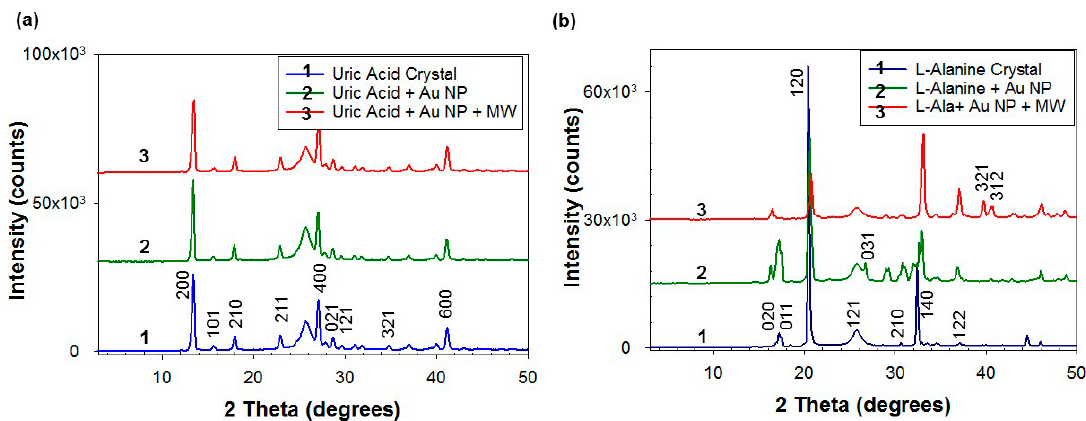
Figure 9. Powder X-ray diffraction (XRD) patterns of ( a ) uric acid before the MAMAD technique is applied (labeled as uric acid crystal), after incubation with gold nanoparticles (uric acid + Au NP) and after the MAMAD technique is applied (uric acid + Au NP + MW) and ( b ) medium L -alanine crystals before the MAMAD technique is applied (labeled as L -alanine crystal), after incubation with gold nanoparticles (Alanine + Au NP) and after the MAMAD technique is applied (Ala. + Au NP + MW).